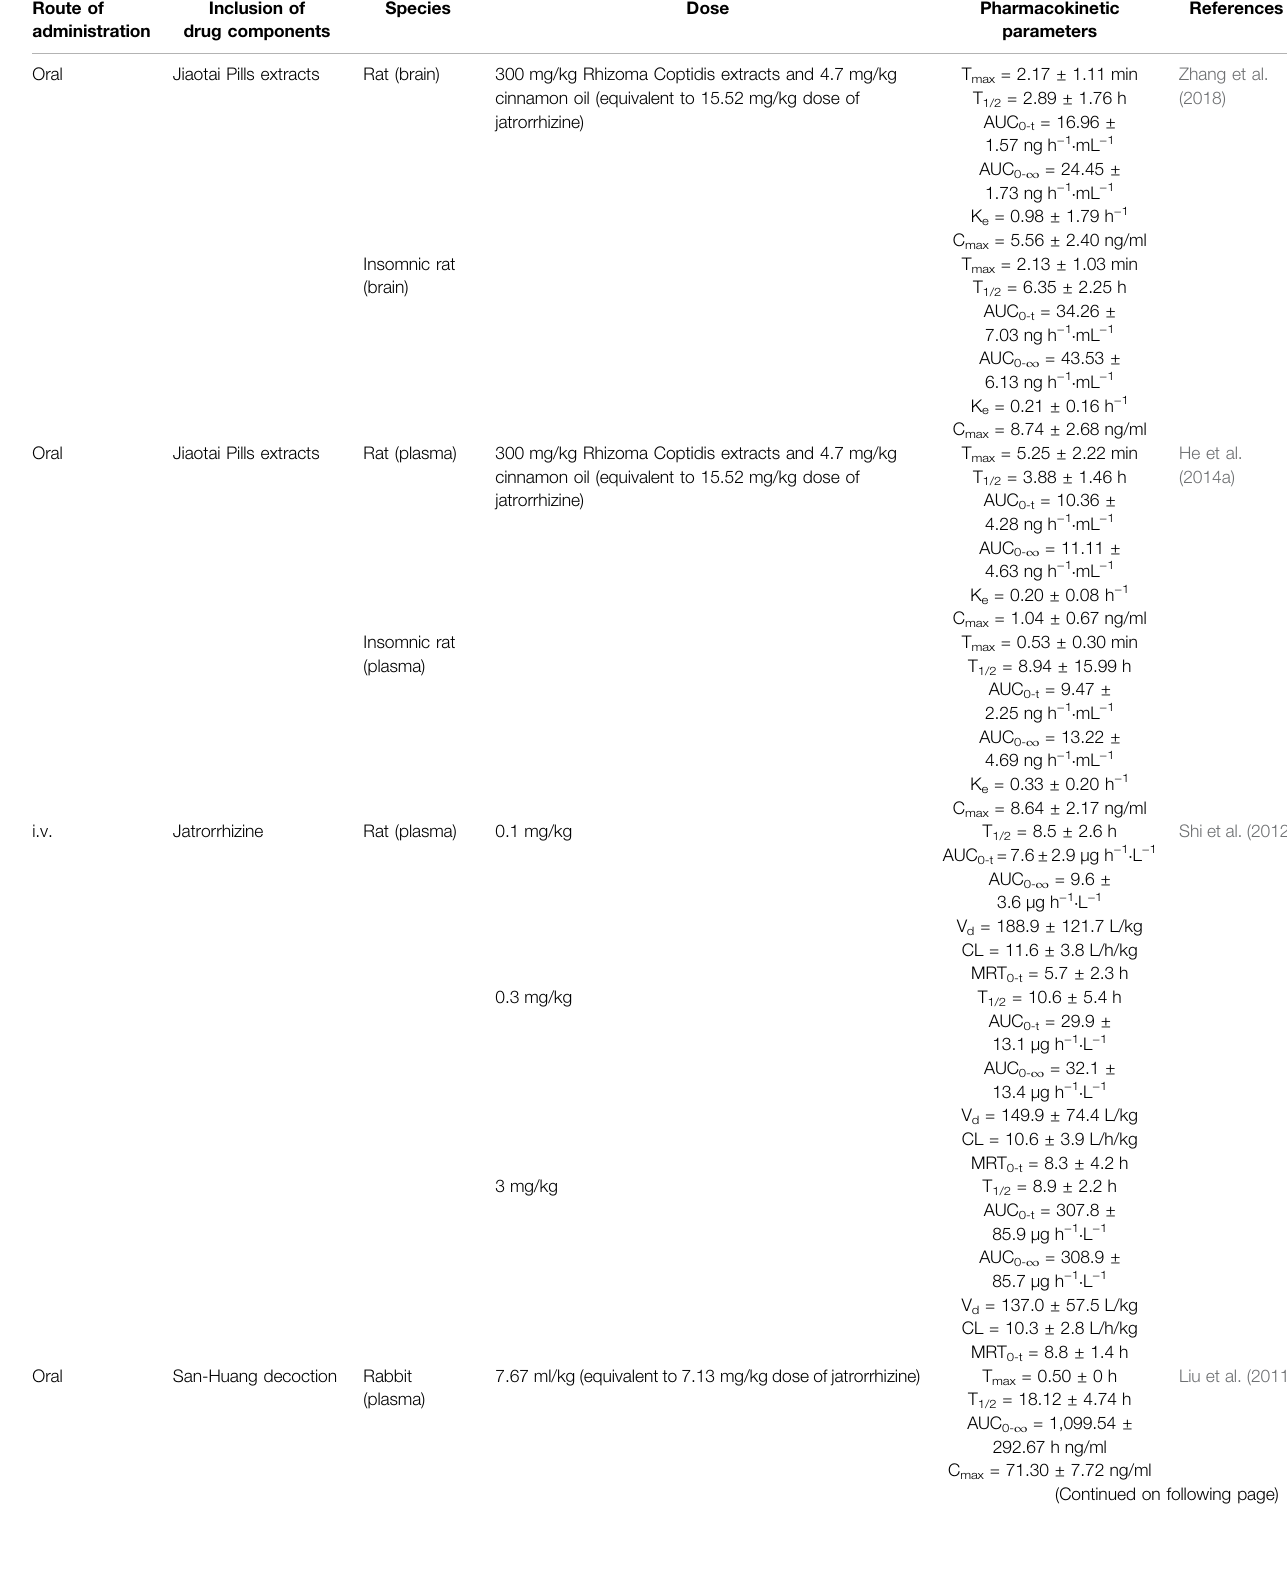
TABLE 4 | Pharmacokinetic parameters of jatrorrhizine. Route of